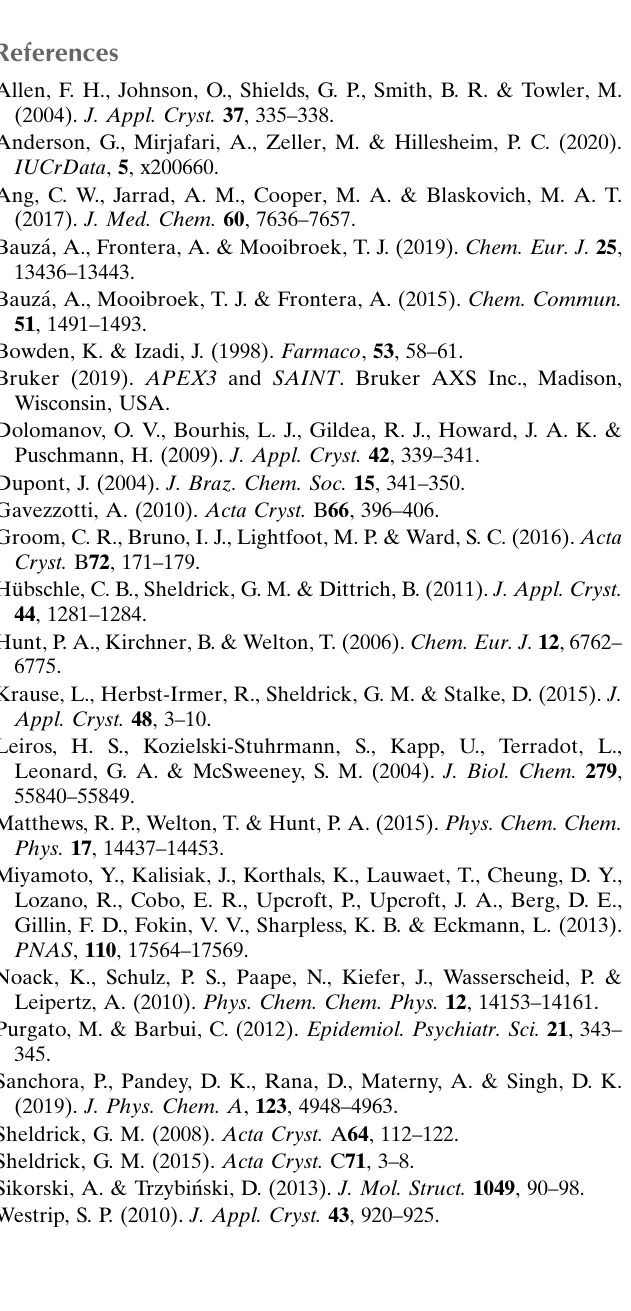
Table 2 Experimental details. Crystal data Chemical